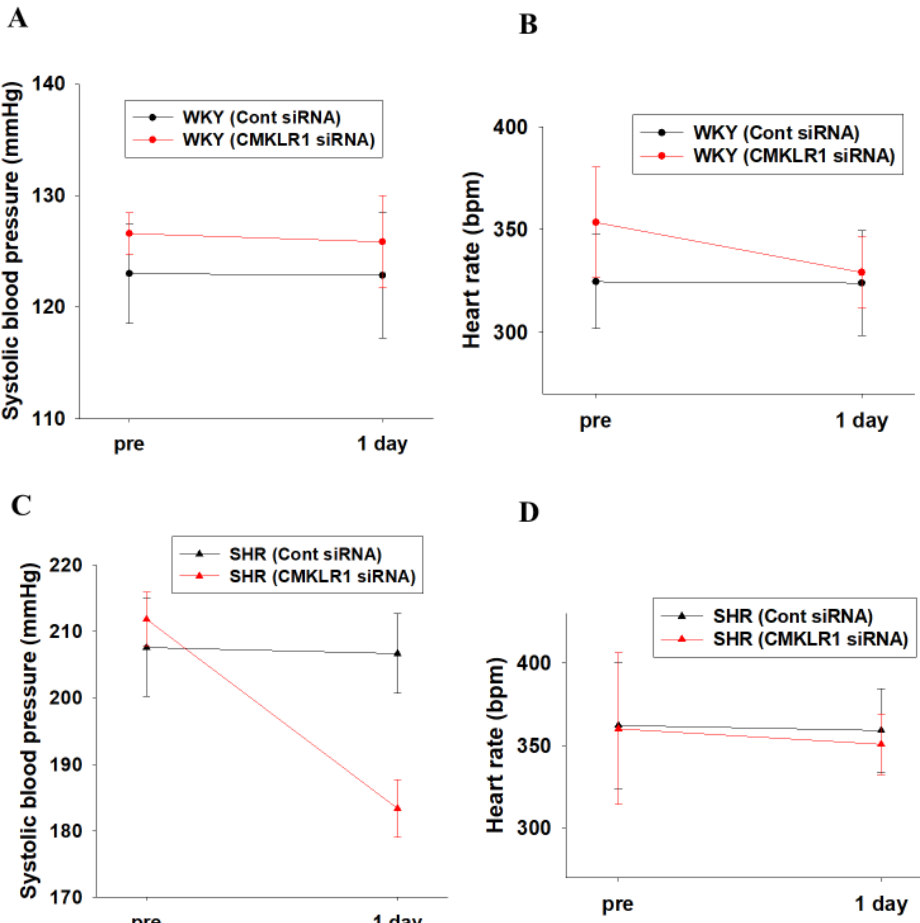
Figure 2. Effects of CMKLR1 small interfering (si)RNA on systolic blood pressure and heart rate in WKY and SHR. Control (Cont) siRNA [0.04 nmol/head, intracerebroventricular (i.c.v.)] or CMKLR1 siRNA (0.04 nmol/head, i.c.v.) was administered to male WKY and SHR for 1 day. Systolic blood pressure ( A , C ) and heart rate ( B , D ) were measured by tail cuff system. Data were shown as mean ± SEM ( n = 4). Pre: before administration of siRNA. 1 day: 1 day after administration of siRNA.